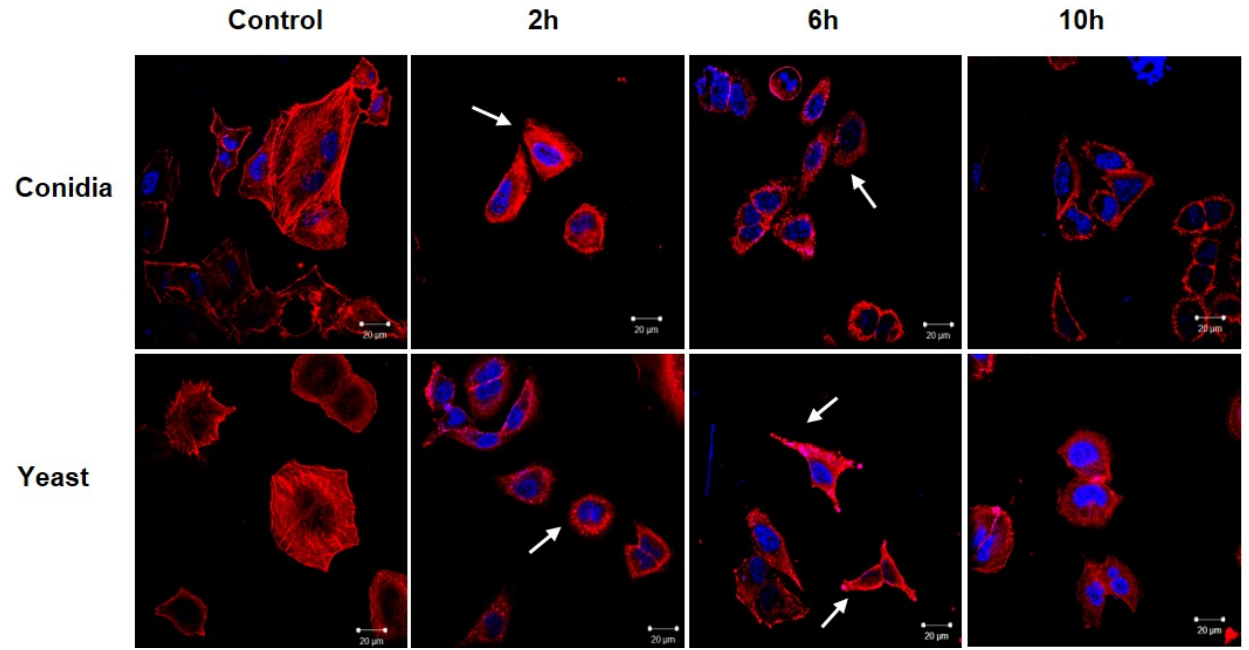
Figure 2. Changes in the cytoskeleton of keratinocytes during infection with conidia and yeast cells of Sporothrix schenckii . Cell infection kinetics were performed with conidia and yeast cells of S. schenckii in keratinocytes at a 1:1 MOI for 10 h. Actin filaments were stained with rhodamine phalloidin (red), and the cell nuclei with DAPI (blue). White arrows indicate the formation of membrane protuberances. Images in 60x.